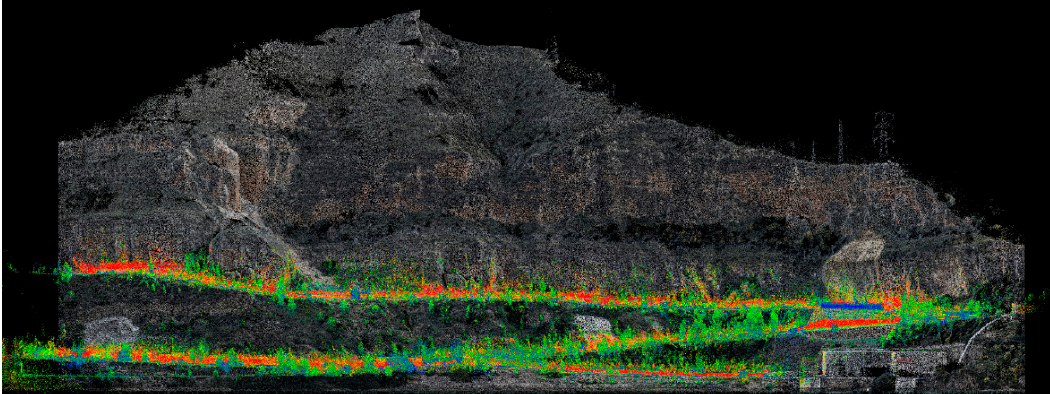
Figure 11. MMS point cloud (false color scale) aligned to the CRP point cloud (red, green and blue (RGB) scale) .